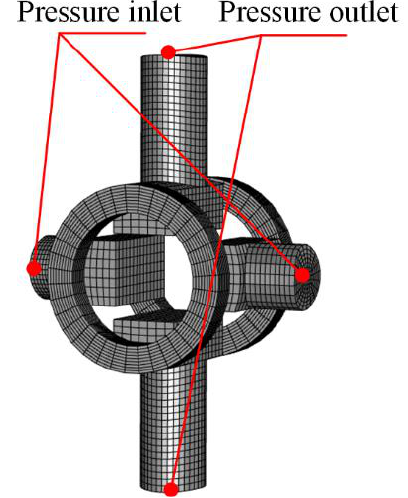
Figure 13. The grid mesh of the pump unit.